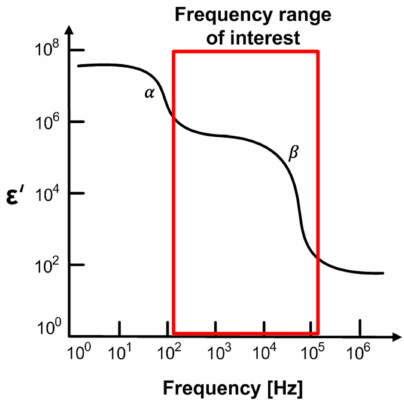
Figure 3. Dispersions of biological